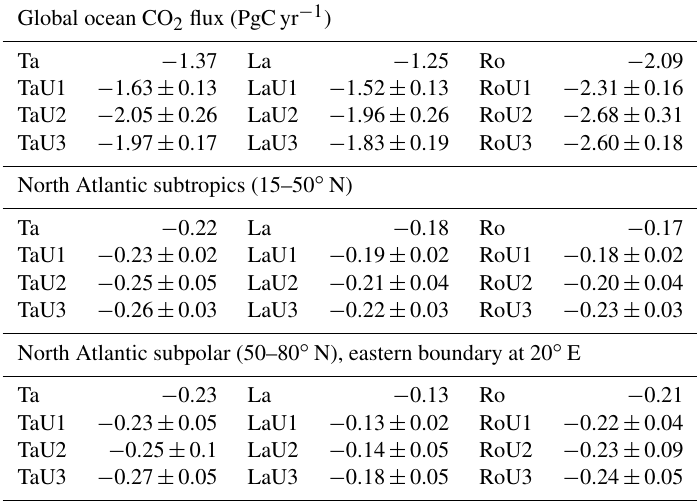
Table 1. Global and North Atlantic CO 2 flux estimates from the GEOS-Chem–LETKF (GCL) system for year 2003 (PgCyr − 1 ), summarizing sensitivity analyses on the prior ocean flux distribution and prior flux uncertainty. Prior flux references are Ta (Takahashi et al., 2009), La (Landschutzer et al., 2016), and Ro (Rodenbeck et al., 2014). Prior flux uncertainty specifications are U1: 60%; U2: 120%; and U3: spread- based scheme (following methods of Sect.